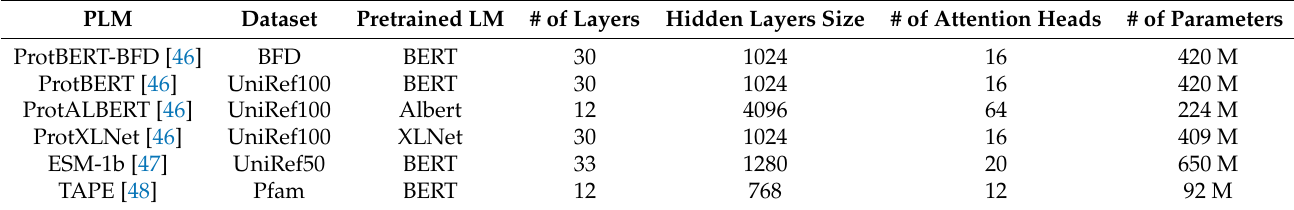
Table 1. Key differences between the six used protein language